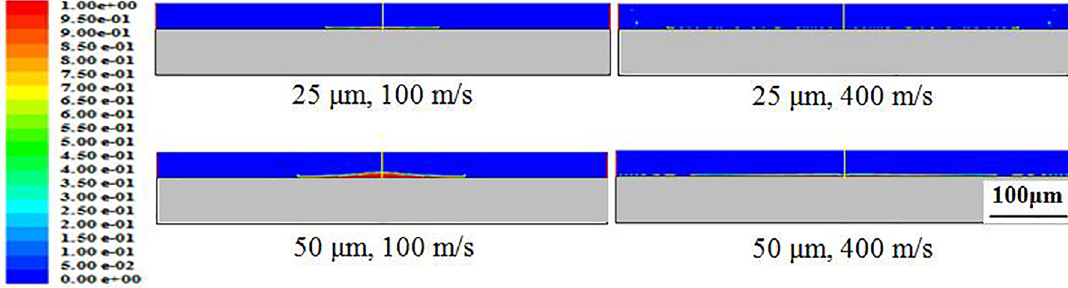
Figure 8. Changes of droplet deformation and solidification with diameter and velocity at 1